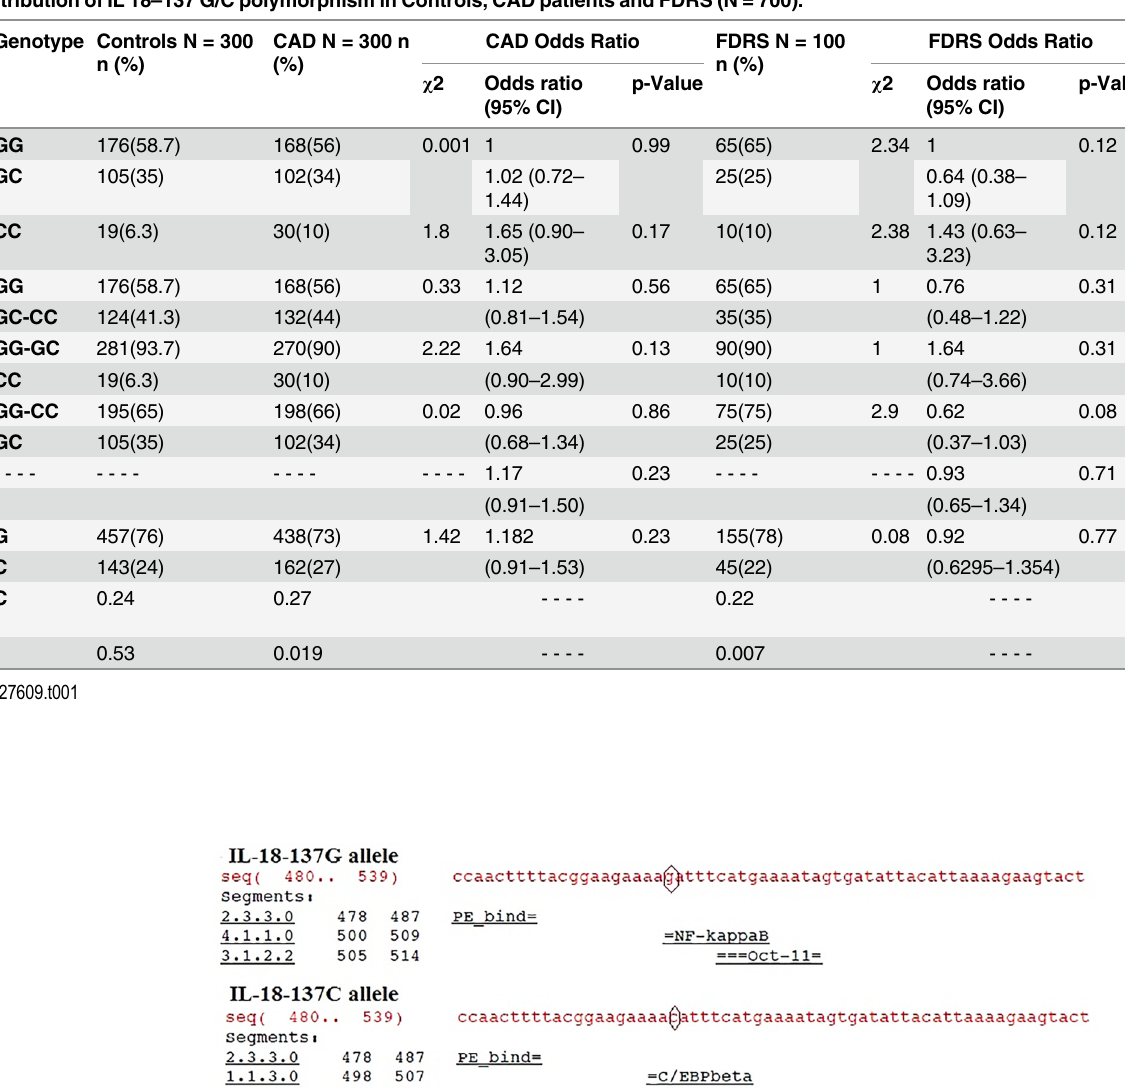
Table 2. Genotype distribution of IL 18 – 137 G/C polymorphism in Controls, CAD patients and FDRS (N = 700).